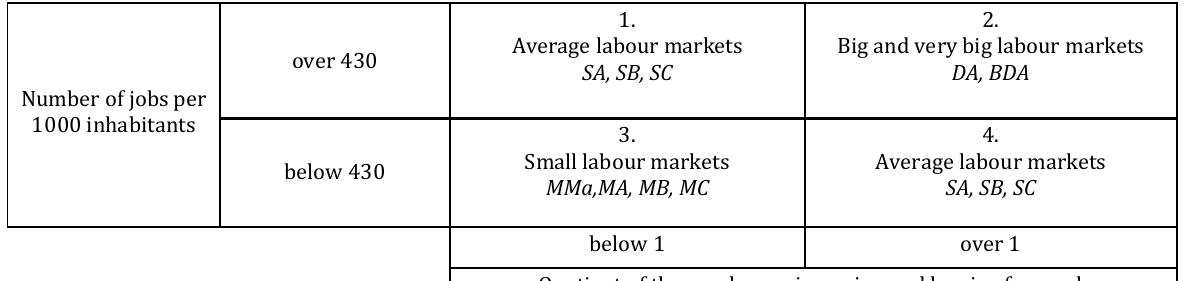
Table 1. The expected position of labour markets resulting from their size (class marking of market size in accordance with Fig. 1)